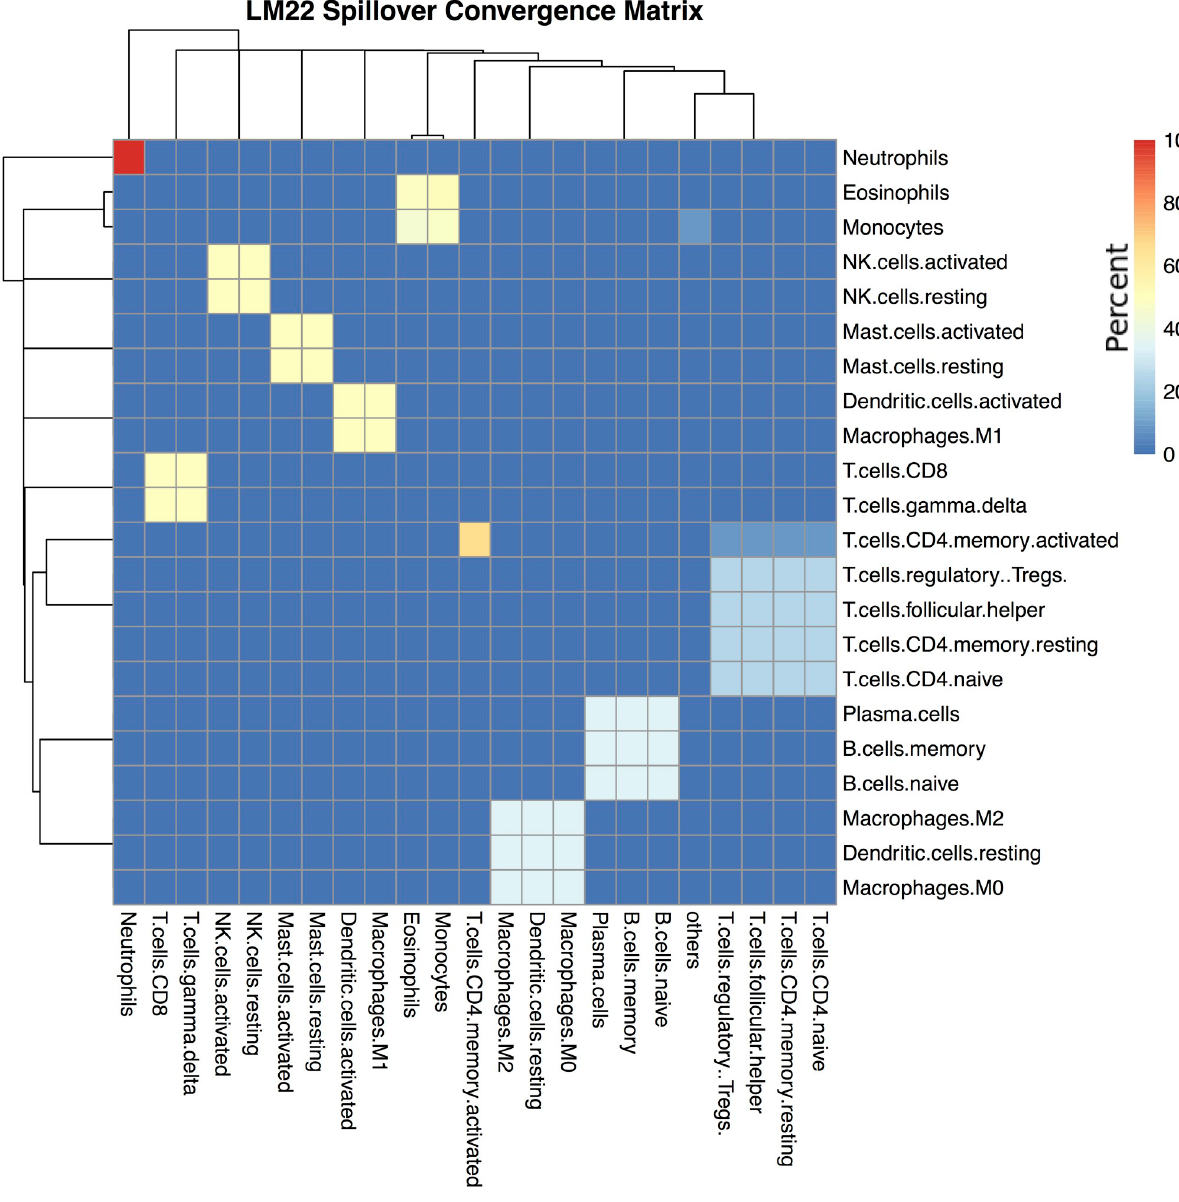
Fig 4. LM22 converged spillover matrix. Iterative deconvolution shows how easily confused cell types conspicuously form clusters. Rows show purified cell types and columns show what those samples deconvolve as. Cells are colored by percentage, such that each row adds up to 100%.